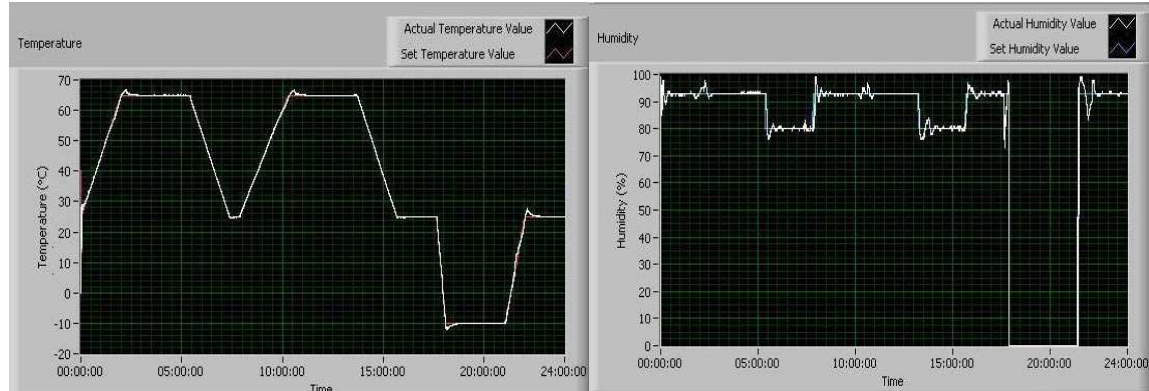
Figure 10. Results of providing environment in the chamber as to standard